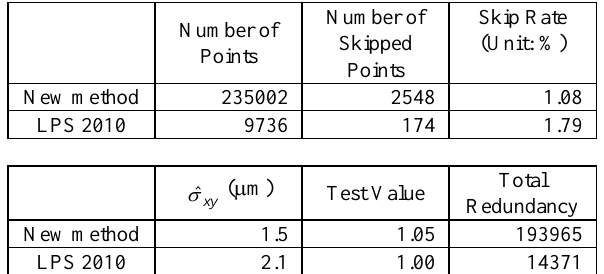
Table 6. Results of free network adjustments done by the new method and